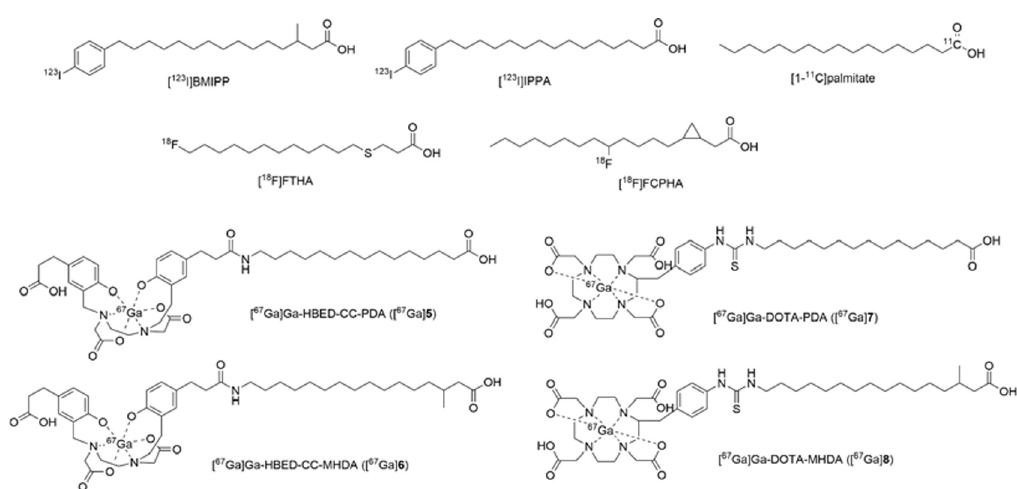
Fig 1. Chemical structures of [ 123 I]BMIPP, [ 123 I]IPPA, [1- 11 C]palmitate, [ 18 F]FCPHA, [ 18 F]FTHA, [ 67